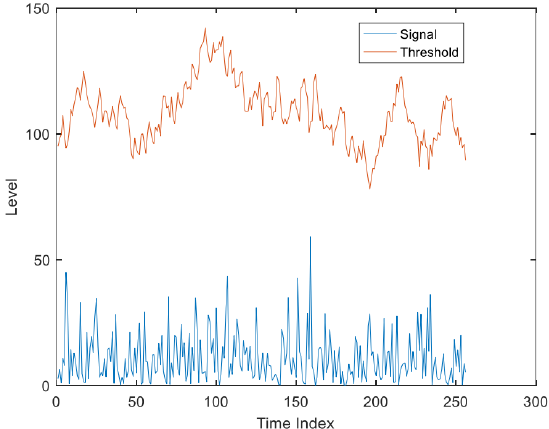
Figure 18. Threshold function output after moving target detection.